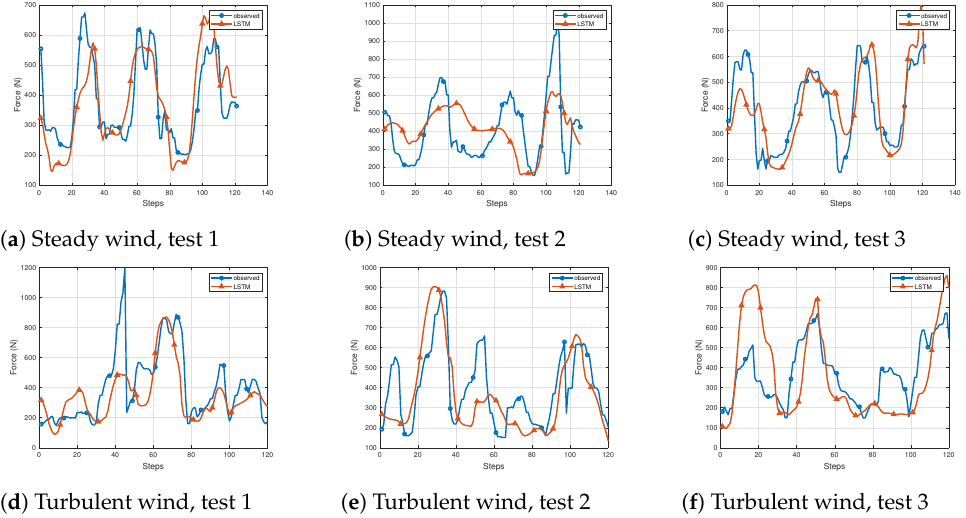
Figure 20. LSTM model test results comparison with the experimental data: ( a – c ) steady wind condition data for the three tests, ( d – f ) turbulent wind condition data for the three